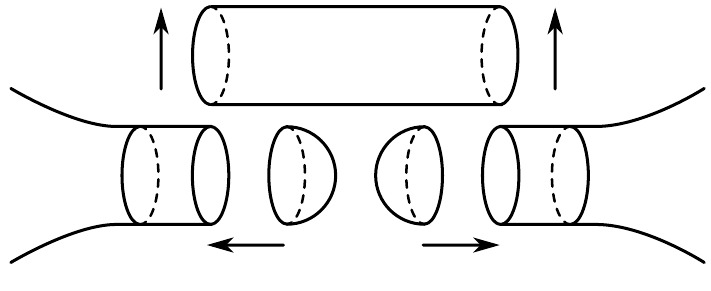
Figure 2 . Schematic of the surgery that is to be done when a neckpinch